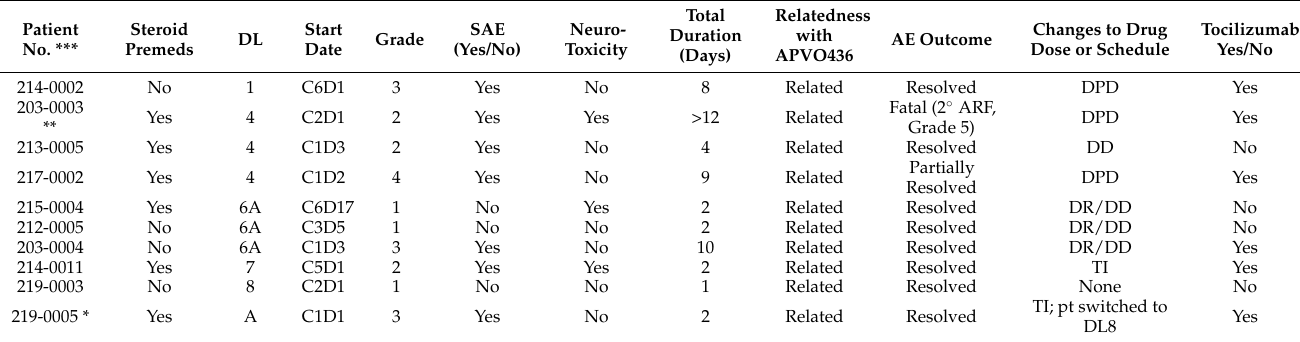
Table 1. Summary tabulation of CRS data (all grades) from study 5001 dose-escalation phase using 2019 ASTCT criteria. Patient Steroid No. ***